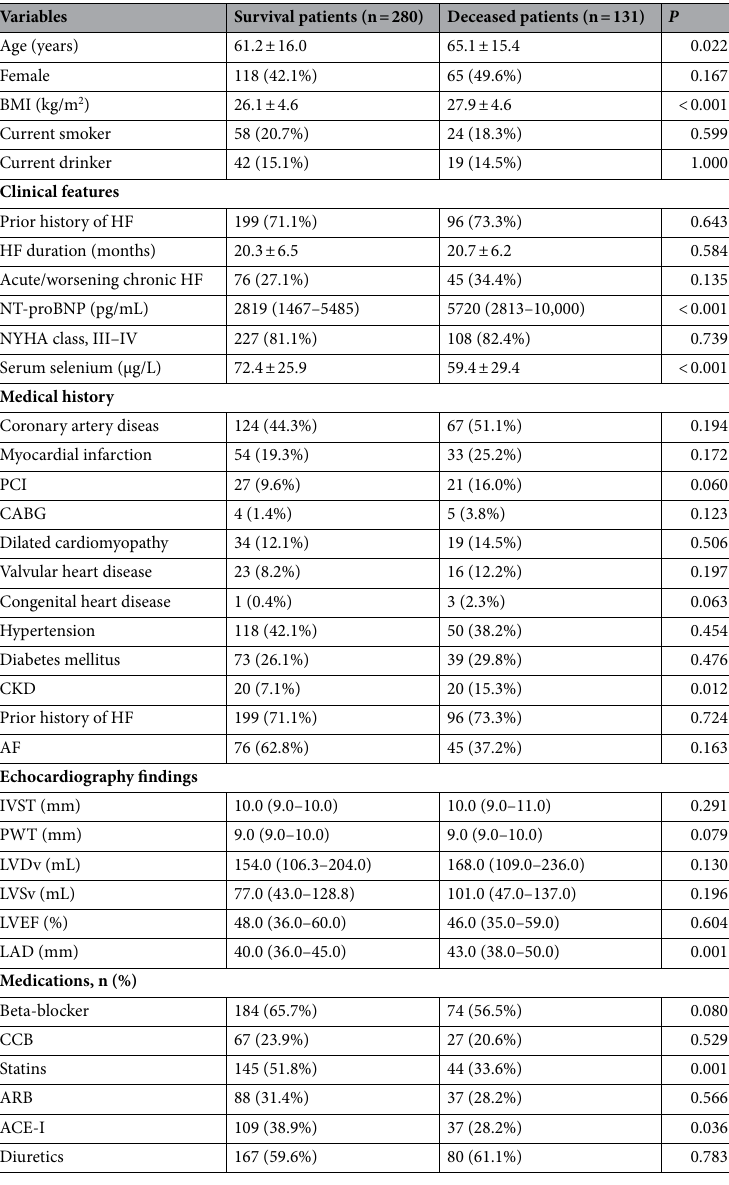
Table 2. Comparison of survival and deceased patients with heart failure. Data are presented as mean (standard deviation), median (interquartile range), or n (%). Abbreviation as in Table